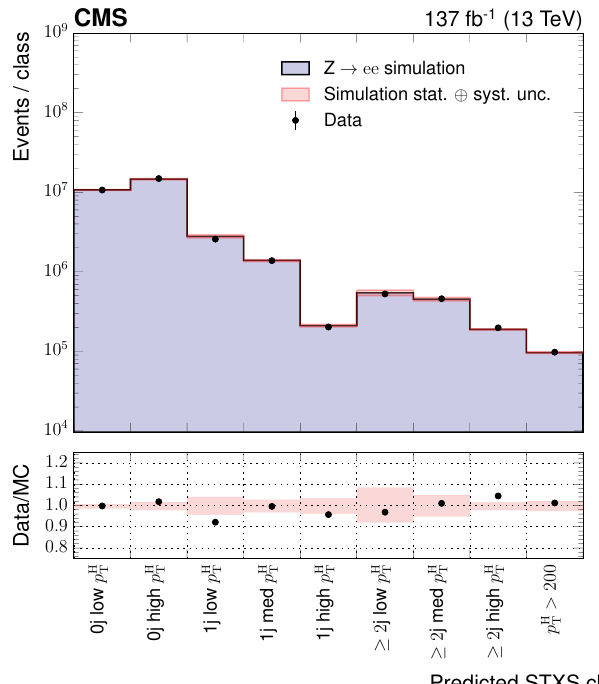
Figure 5 . The most probable STXS class from the ggH BDT in Z → ee events where the electrons are reconstructed as photons is shown. The points show the predicted class for data, whilst the histogram shows predicted score for simulated Drell-Yan events, including statistical and systematic uncertainties (pink band). The full data set collected in 2016–2018 and the corresponding simulation are